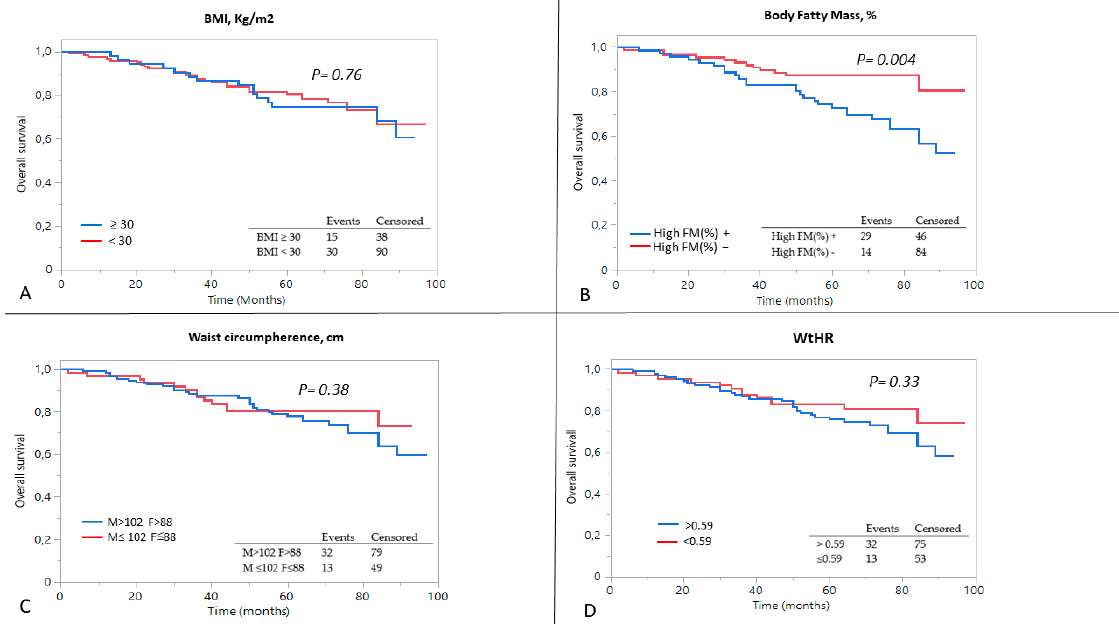
Figure 3. Kaplan–Meier curves for the mortality outcome, after dividing the patients on the basis of ( A ) BMI, ( B ) percentage of body fat mass, ( C ) waist circumference and ( D ) waist-to-height ratio. A log-rank analysis was conducted. Table 3. Conditions associated with: (A) mortality, (B) dialysis and (C) composite outcome, in uni- variate and multivariable Cox regression model adjusted for baseline covariates (age, gender and presence of type 2 diabetes).